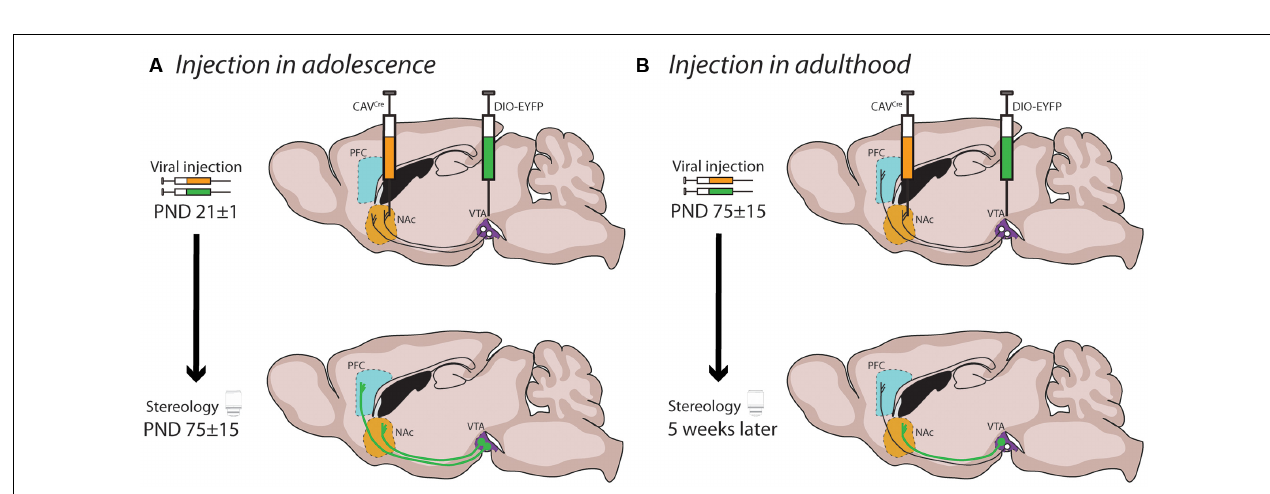
FIGURE 4 | Mesocortical axon growth in adolescence revealed by an intersectional viral labeling technique. (A) Spatiotemporally specific labeling of DA neurons with axons present in the NAc at PND21 reveals that DA axons continue to grow to the PFC in adolescence. (B) Labeled DA axons are not found in the PFC of mice when subjected to the same manipulation in adulthood, supporting previous findings that DA neurons do not commonly send collaterals between these